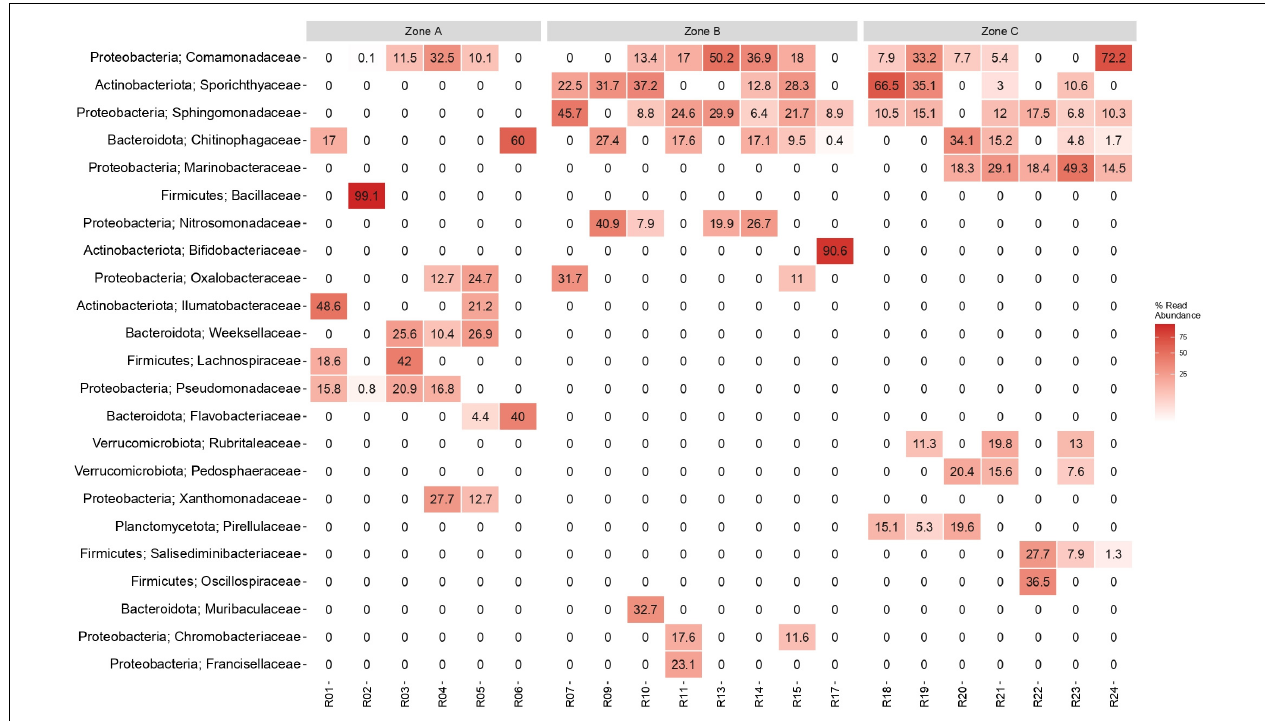
FIGURE 5 | Most abundant bacterial families in samples of the soil profile in the hyperarid core of the Atacama Desert. The heatmap shows the top 10 most abundant families per zone (total 23 families). Taxa are sorted according to overall abundance (%). R01: (0–10 cm); R02: (10–20 cm); R03: (20–30 cm); R04: (30–40 cm); R05: (40–50 cm); R06: (50–60 cm); R07: (60–70 cm); R09: (80–90 cm); R10: (90–100 cm); R11: (100–110 cm); R13: (120–130 cm); R14: (130–140 cm); R15: (140–150 cm); R17: (210–220 cm); R18: (240–250 cm); R19: (250–260 cm); R20: (260–270 cm); R21: (270–280 cm); R22: (290–300 cm); R23: (320–330 cm); R24: (330–340